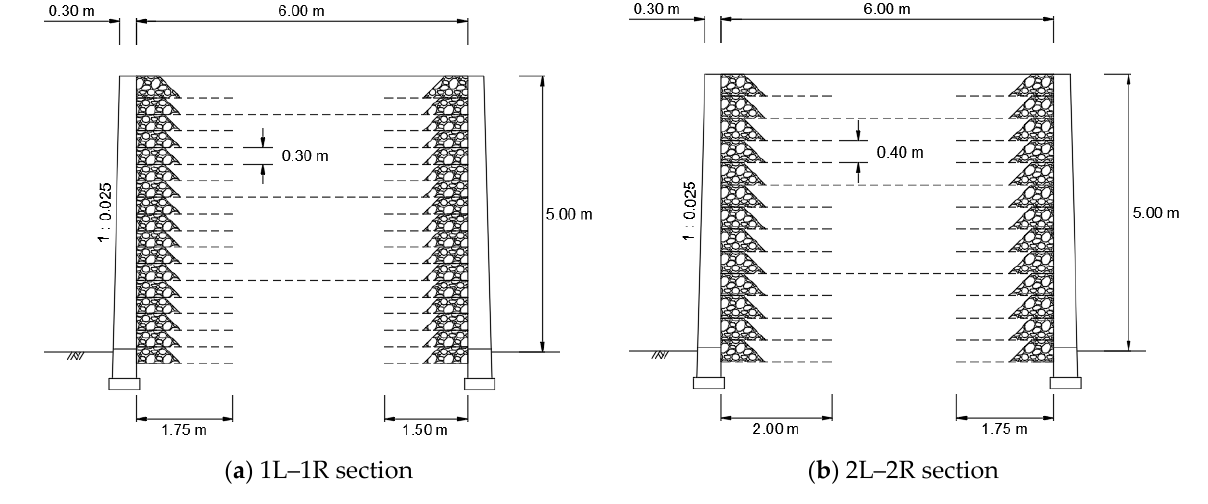
Figure 2. Schematic of the full scale RSR.